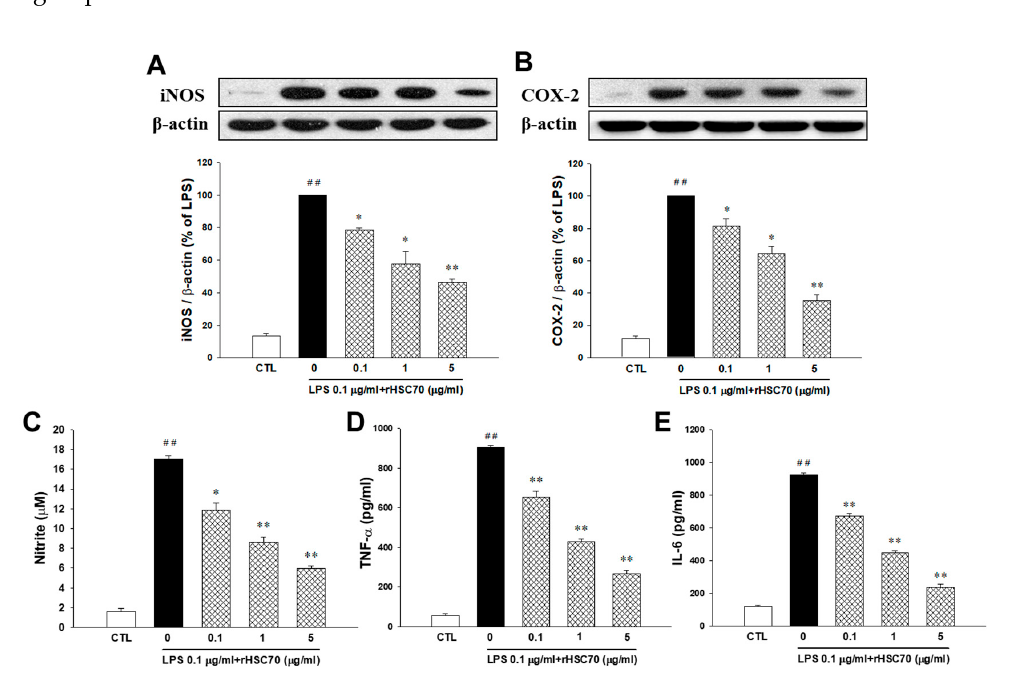
Figure 1. Effects of rHSC70 on LPS-induced iNOS ( A ) and COX-2 ( B ) expression, nitrite ( C ), TNF- α ( D ) and IL-6 ( E ) production in RAW264.7 cells. Cells were pretreated with recombinant heat shock cognate protein 70 (rHSC70; 0.1, 1 and 5 µg/mL) for 5 min before LPS treatment and protein samples were prepared 24 h after LPS treatment. Densitometric analysis showed that the relative expression level of iNOS and COX-2. The β -actin was used as a loading control. Significant differences were identified by One-Way ANOVA followed by Dunnett’s test. Each value represents as mean ± SEM of three independent experiments, with triplicate determinations in each experiment. ## p < 0.01 versus control group (CTL); * p < 0.05, ** p < 0.01 versus LPS